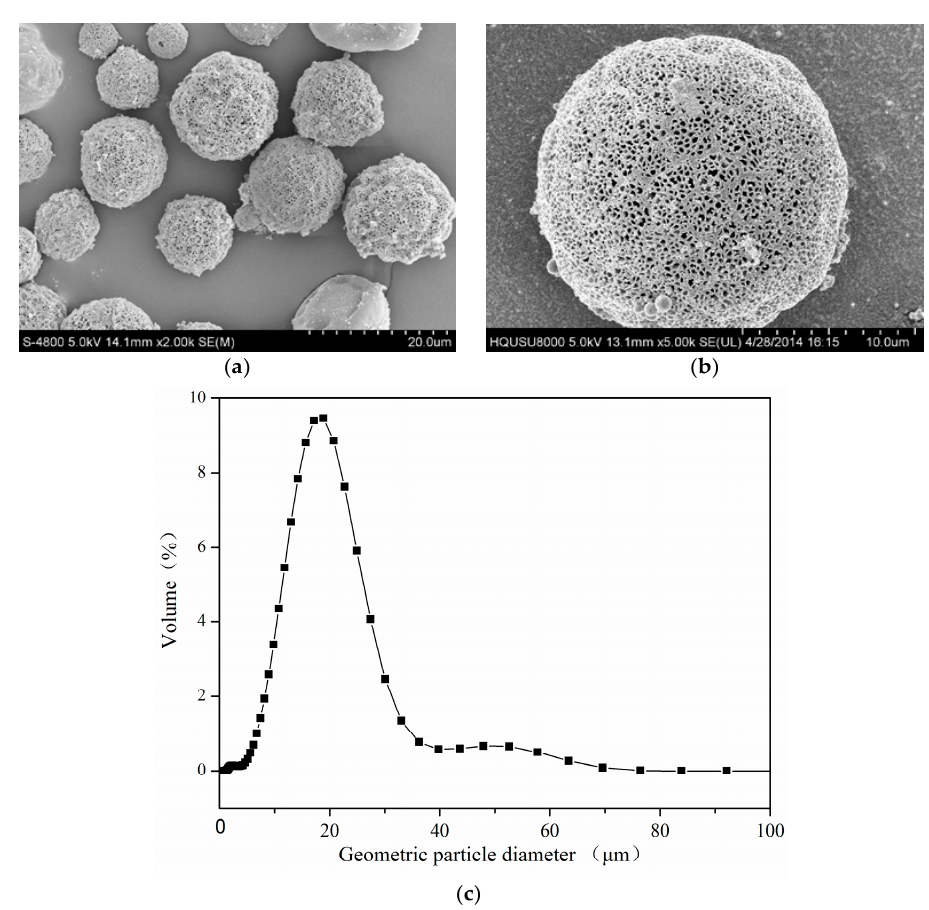
Figure 3. SEM image and particle size distribution of PLLA PMs. ( a ) ×2 k; ( b ) ×5 k; and ( c ) particle size distribution of PLLA PMs.